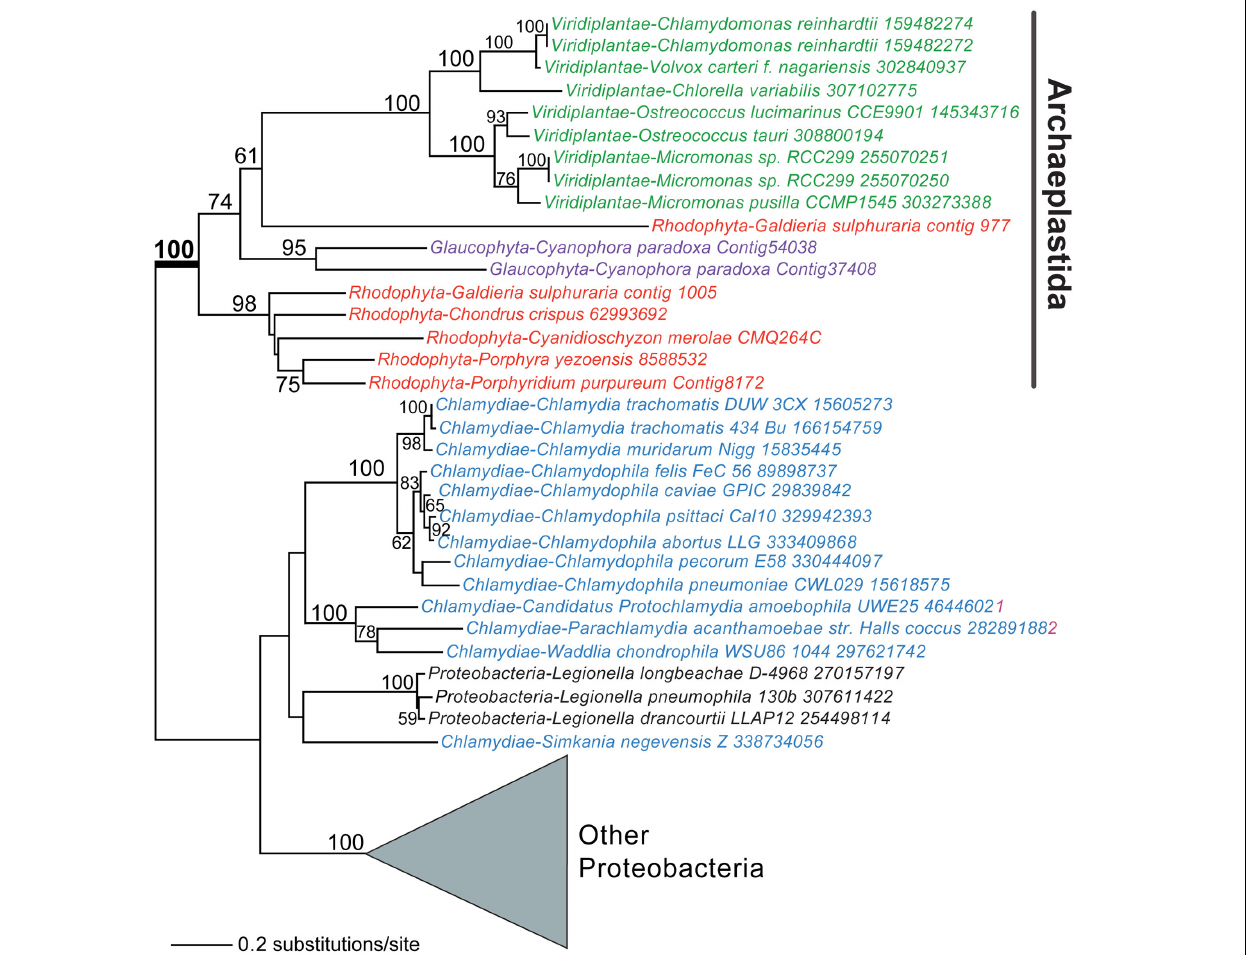
details, see Price et al., 2012). Bootstrap values (when ≥ 50%) are shown at the branches. Red algae, Viridiplantae, glaucophytes, and Chlamydiae are shown in red, green, magenta, and blue text,